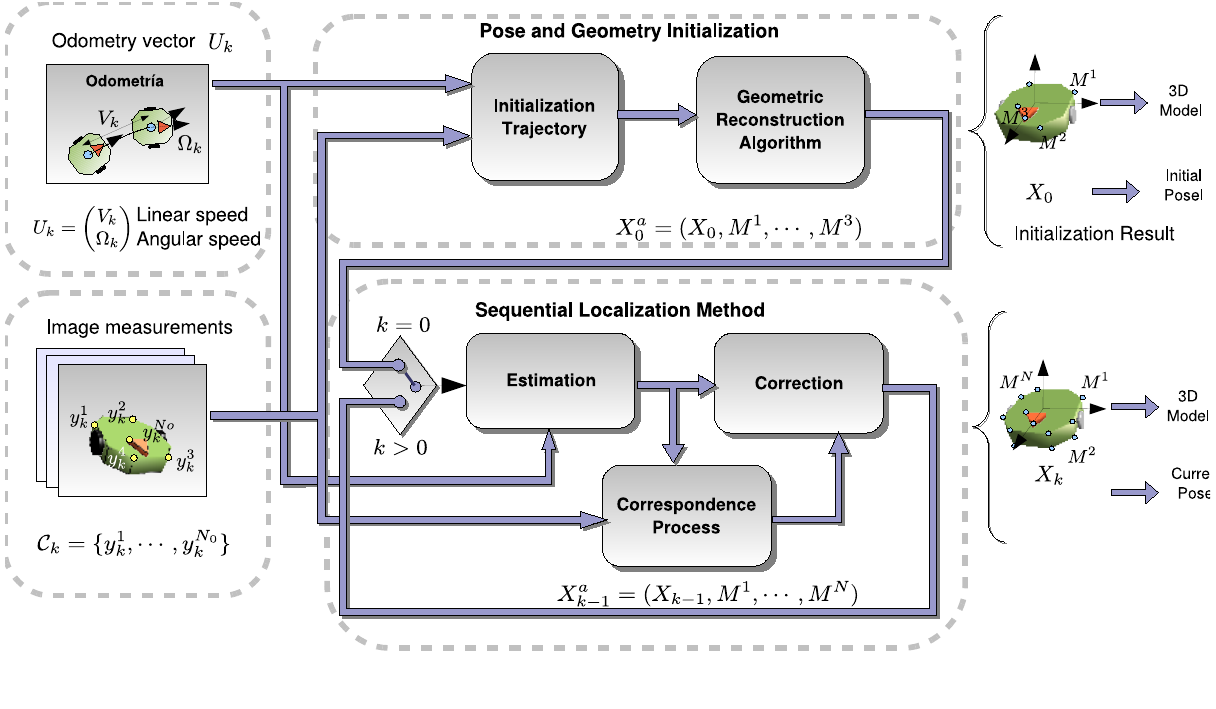
Figure 1. General diagram of the proposed localization system using a vision sensor and odometry